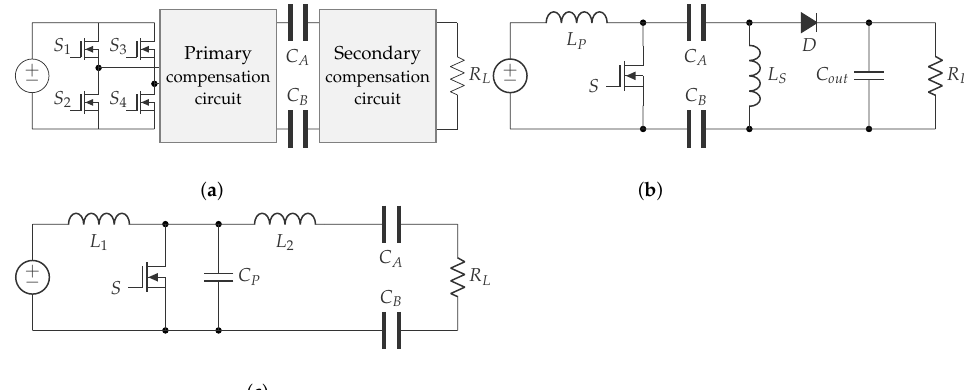
Figure 15. Circuit topologies for the realization of CPT systems. ( a ) General full-bridge inverter. ( b ) Modified PWM-based SEPIC converter. ( c ) Modified class-E